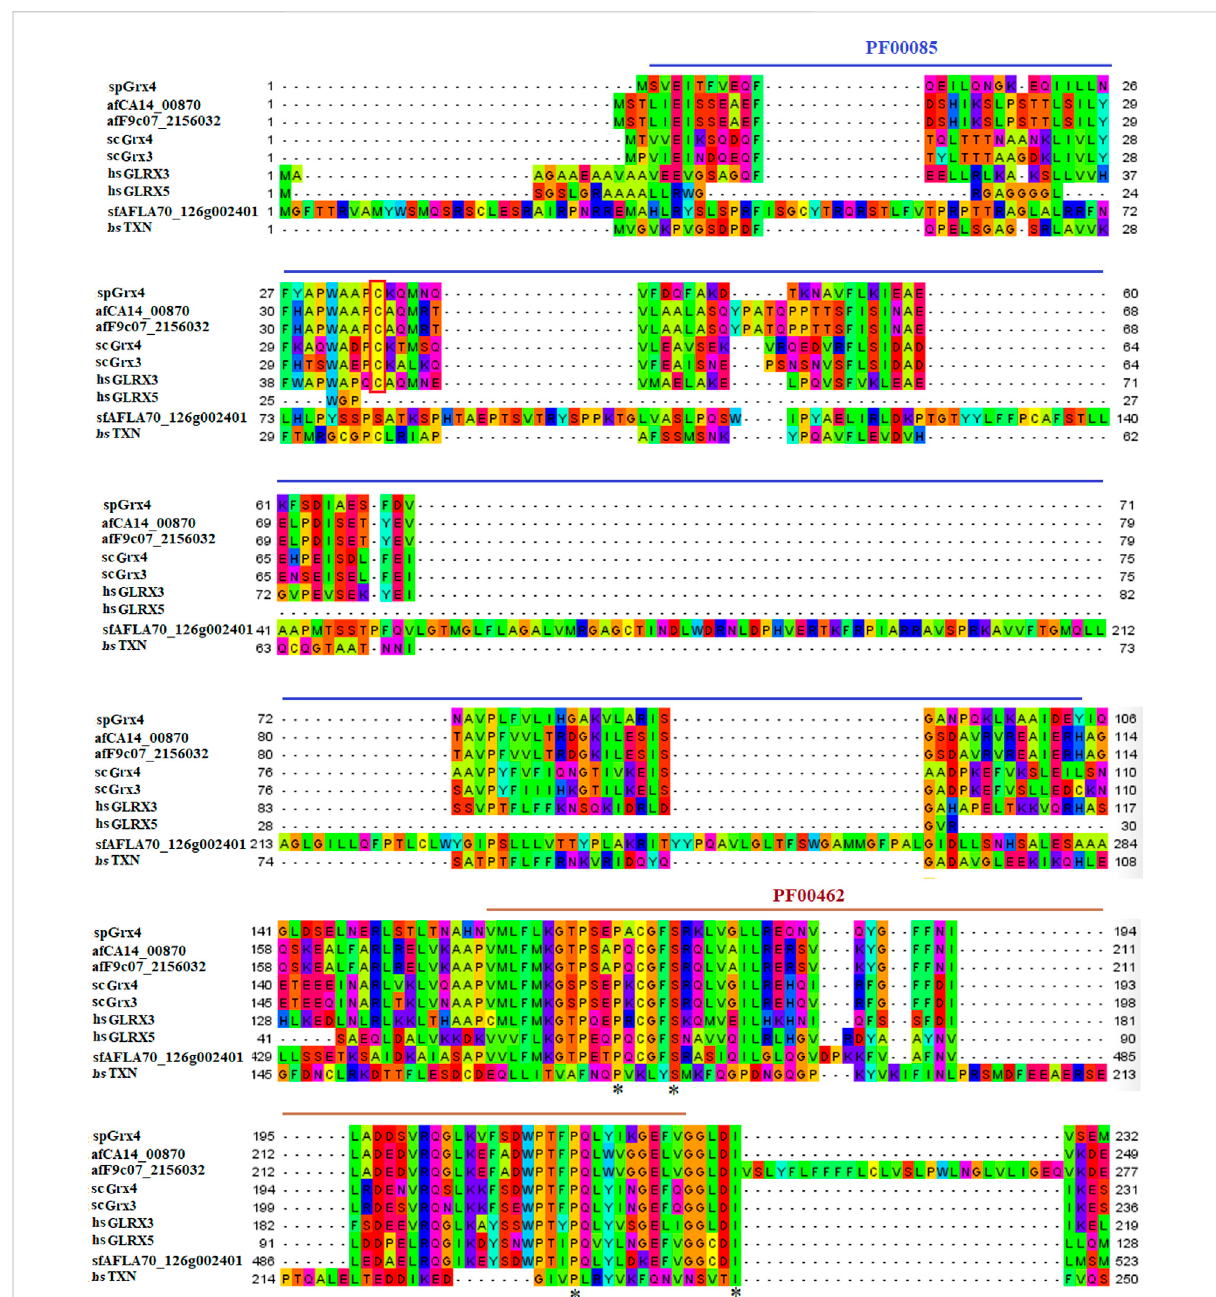
FIGURE 2 MultiplesequencealignmentofthePF00085andPF00462domainsequencesinspGrxp4anditssequencehomologsin A. fl avus,S.cerevisiae , and humans using the MEGAX10.1.8 software. The Grx4 domains were discovered through a search of the SMART database. The two characteristic residues (a Cys residue in the PF00085 domain and a Cys172 residue in the PF00462 domain) are enclosed in square brackets. They are highlighted according to the biochemical properties of the amino acid